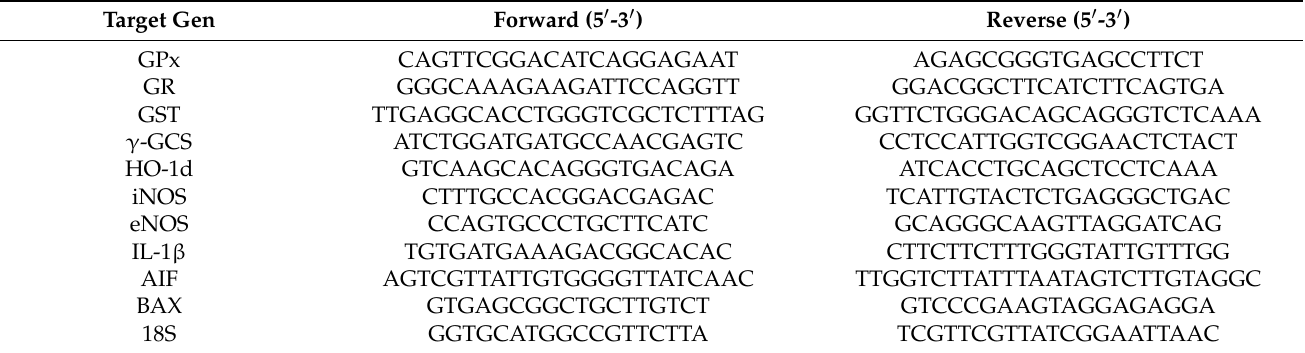
Table 1. Primer sequences for quantitative real-time